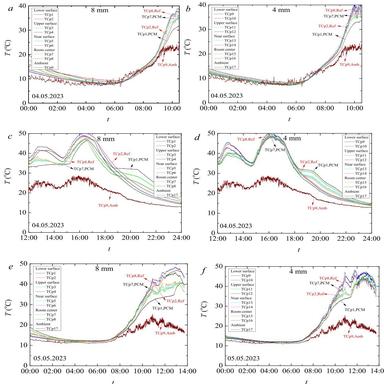
Temperature variation in the test room (3D-SLA/MEPCM-40) and reference rooms (3D-SLA/MEPCM-0) for 8 mm (a), (c), (e) for 4 mm (b), (d), (f).